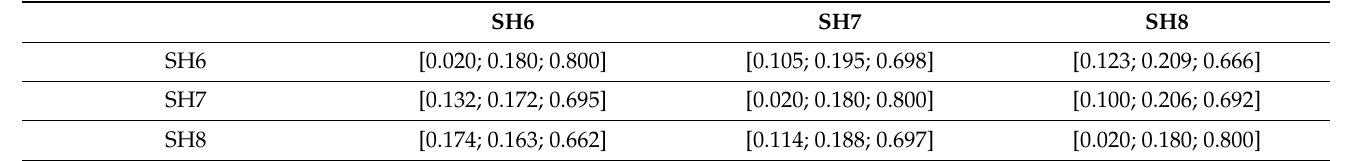
Table 2. Aggregated matrix—healthcare equipment sub-criteria.